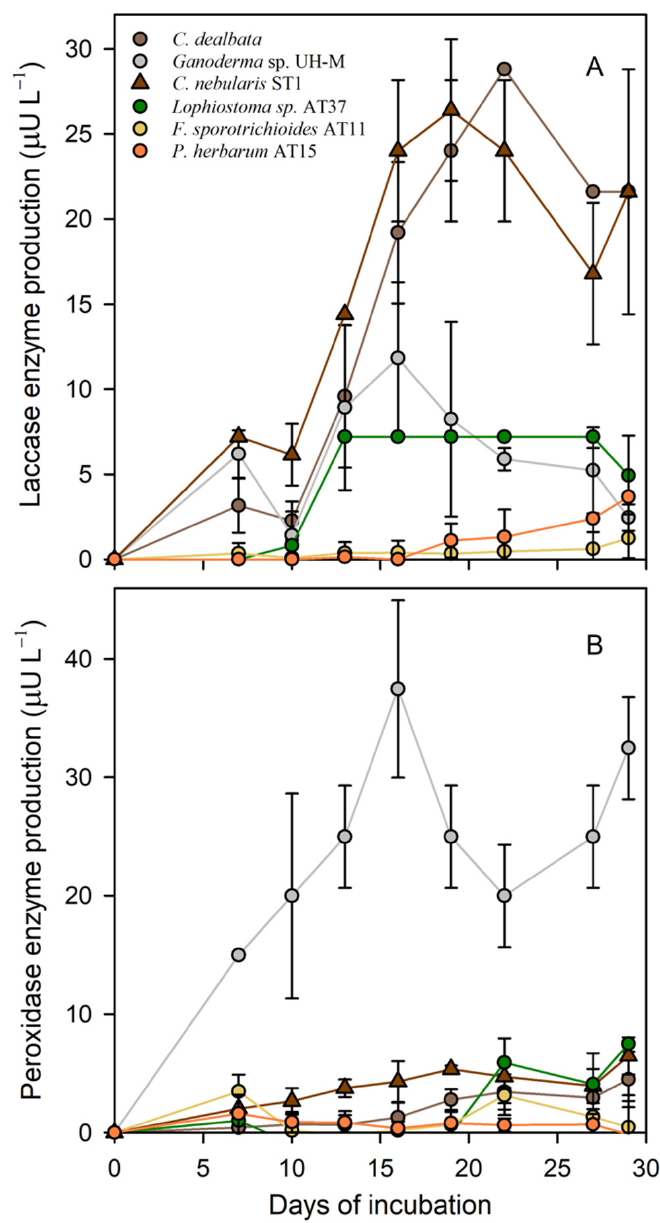
Figure 3. Enzyme activity. ( A ) Laccase and ( B ) peroxidase produced by time and represented as a mean of three replicates for the fungal strains Lophiostoma sp. AT37 (green), F. sporotrichioides AT11 (yellow), and P. herbarum AT15 (orange) and three strains used as control (grey).